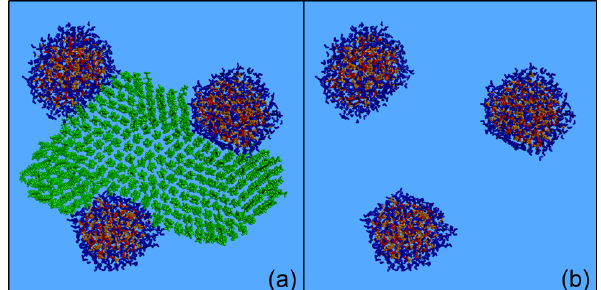
Figure 7. Characteristic snapshot from the MD simulation of the nanoparticle containing n -eicosane (63% dry) at 76% RH, (a) in- cluding and (b) omitting n -eicosane molecules. Colour coding: green for n -eicosane, red for sulfate, orange for ammonium and blue for water. Figure 8. Percentage of (a) CPA molecules, (b) water molecules